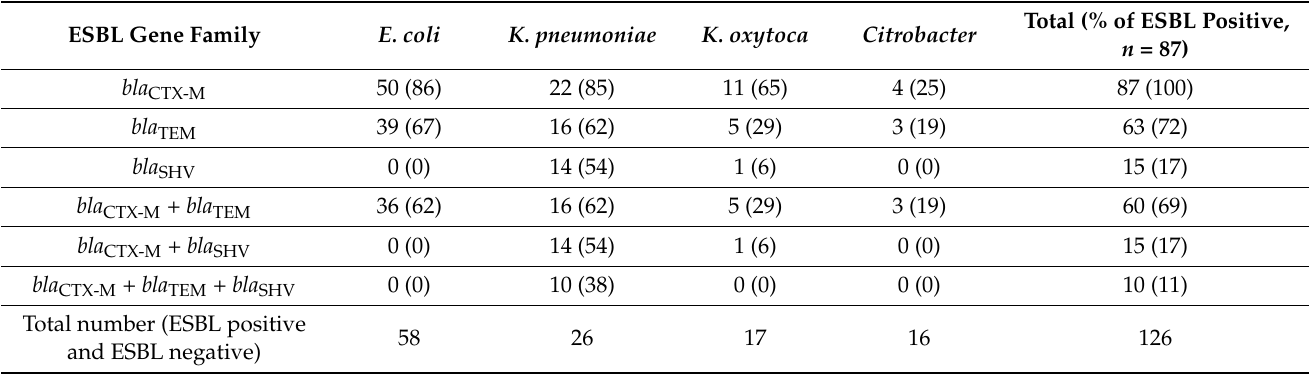
Table 7. The number and percentage distribution and co-occurrence of bla CTX-M , bla TEM , and bla SHV genes among the ESBL positive